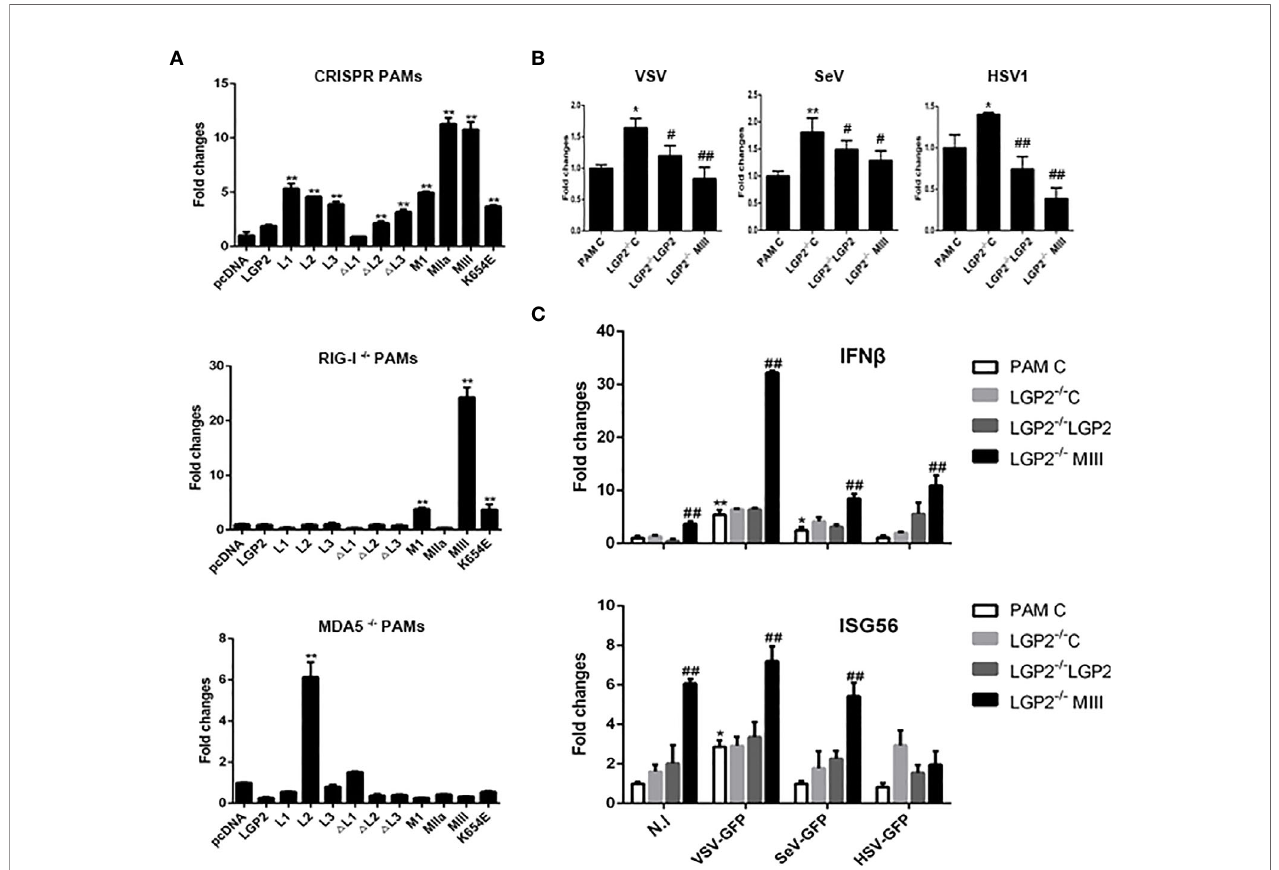
FIGURE 9 | The porcine LGP2 mutant activity in RIG -/- and MDA5 -/- PAMs and the antiviral activity. (A) RIG -/- , MDA5 -/- and CRISPR control PAMs in 12-well plates (5×10 5 cells) were transfected with pLGP2 and its mutants (0.75 m g each). Twenty-four hours later, the cells were analyzed by RT-qPCR for the downstream IFN b gene transcriptions. ** p < 0.01 vs pcDNA controls. (B, C) LGP2 -/- PAMs were transfected with 0.75 m g pLGP2, its constitutive MIII mutant or pcDNA control (C) for 24 h. PAMs transfected with pcDNA was used as a control (PAM C). The transfected cells were infected with 0.01 MOI VSV, SeV and HSV-1 for 8 h, and analyzed by RT-qPCR for virus replications (B) , as well as for cellular downstream IFN b and ISG56 expressions (C) . * p < 0.05, ** p < 0.01 vs PAM C or N. I # p < 0.05, ## p < 0.01 vs LGP2 -/- PAM